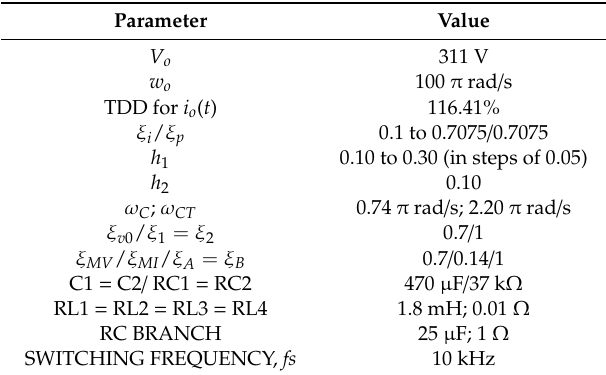
Table 3. Simulation parameters.